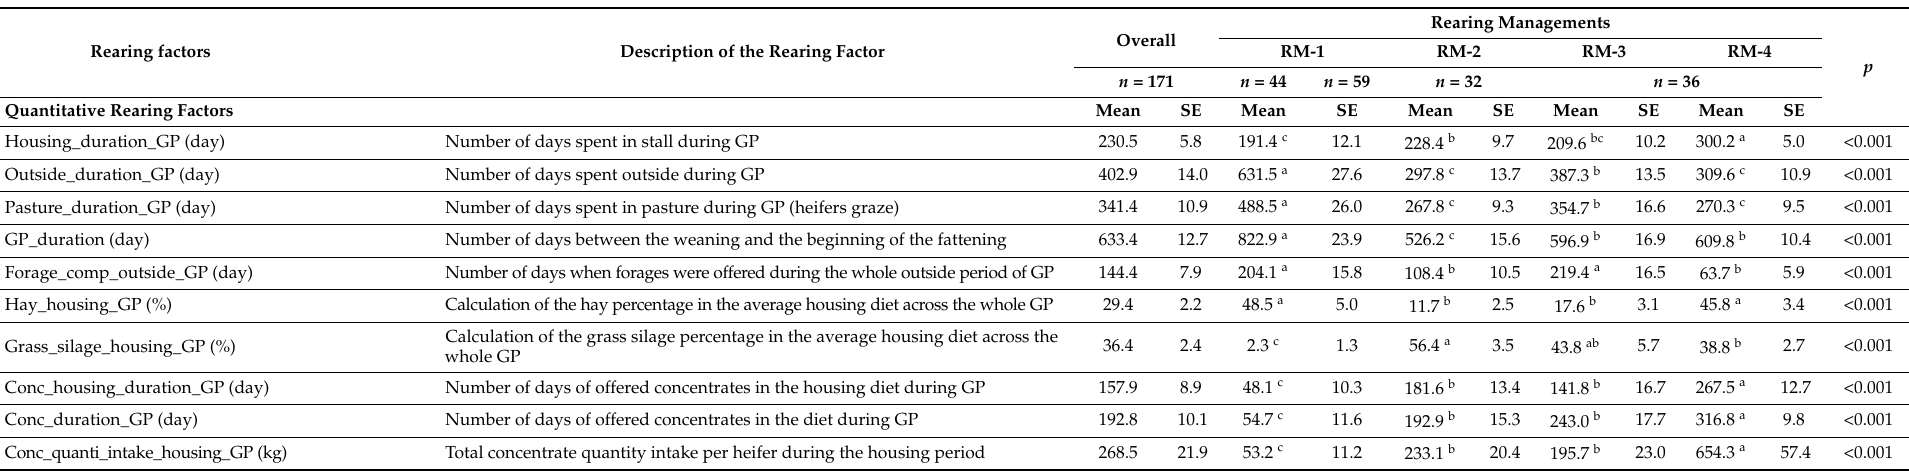
Table 2. Rearing factors characterizing the growth period (GP) of the rearing managements (RM) applied during the heifers’ whole